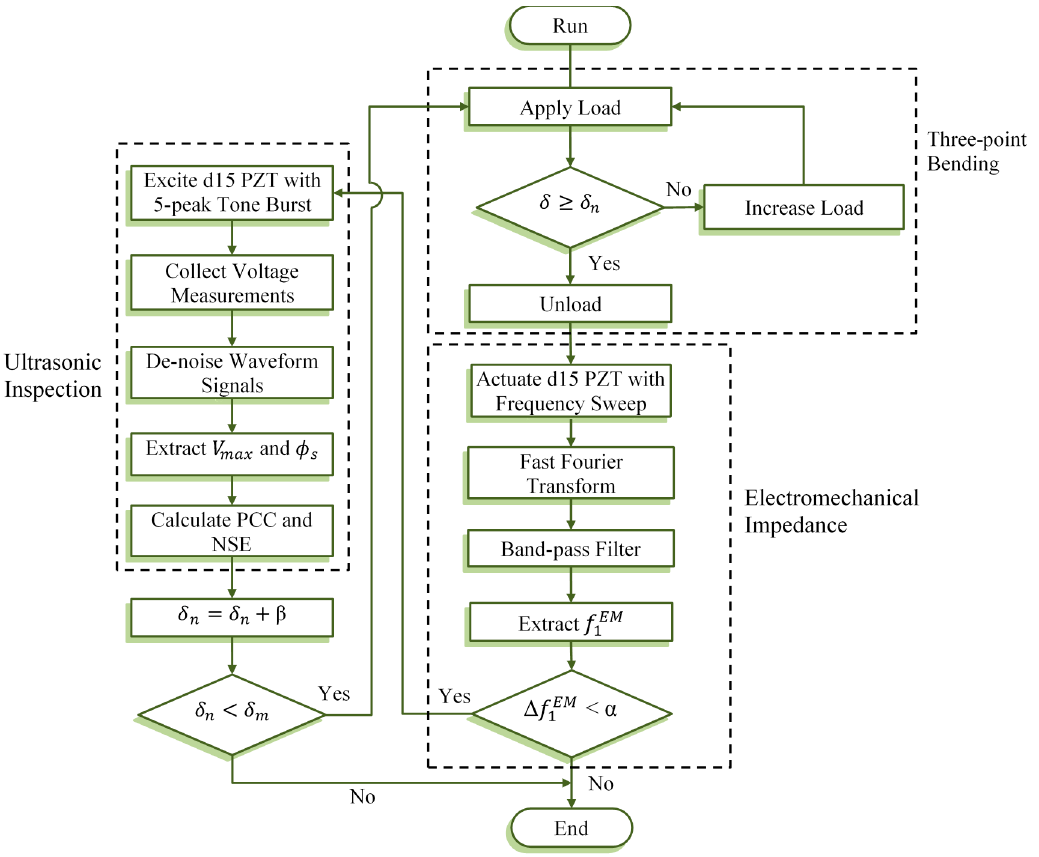
Figure 5. Flowchart of ultrasonic health monitoring experiment for a laminate specimen with surface- surface-mounted and bondline-embedded PZT mounted and bondline-embedded PZT transducers.